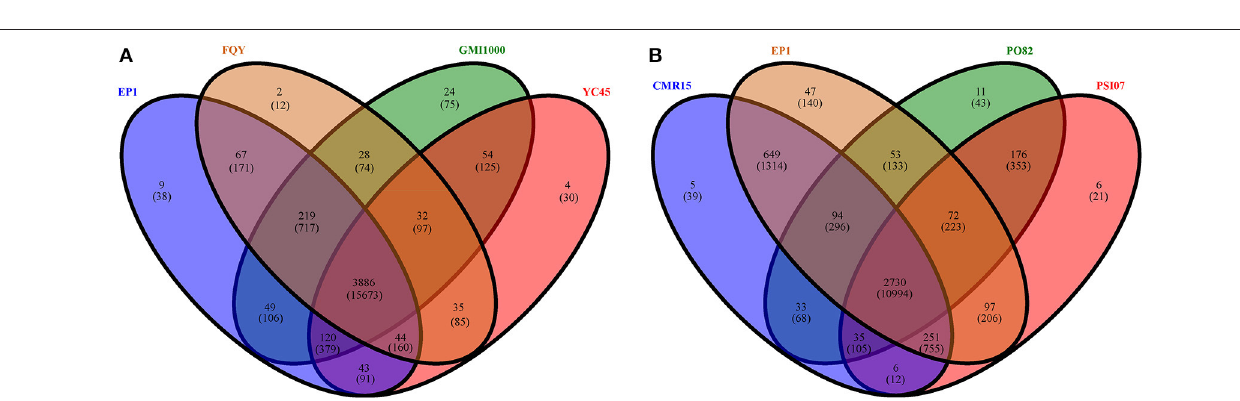
(phylotype II), CMR15 (phylotype III), and PSI07